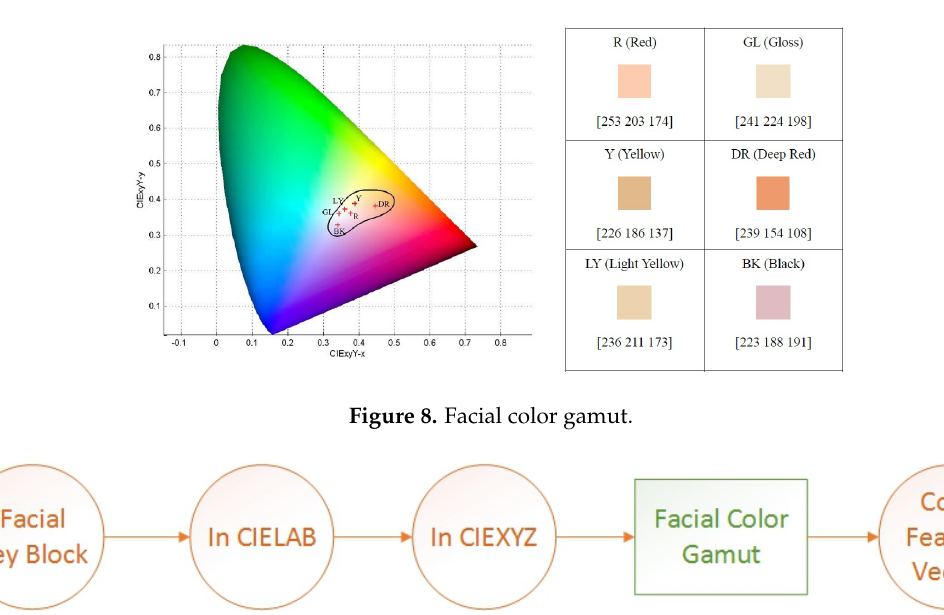
Figure 9. Facial key block color feature extraction